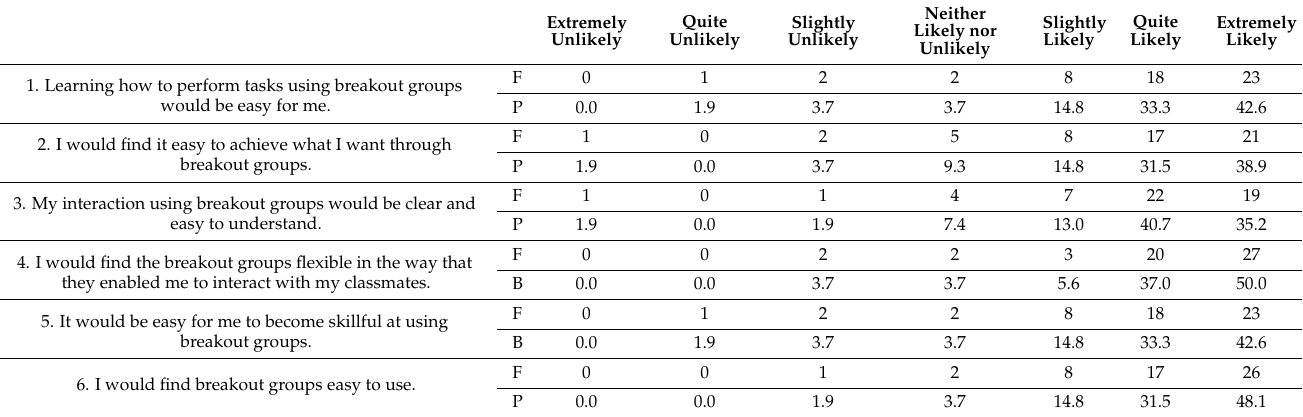
Table 12. Table of frequency for perceived ease of use.